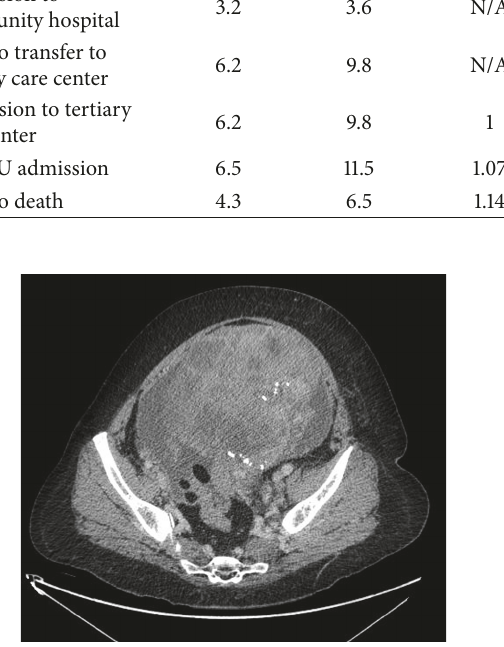
Figure 1: CT scan of the abdomen showing a large heterogeneous, partially necrotic abdominal-pelvic mass, 16.3 cm by 20.2 cm in size.